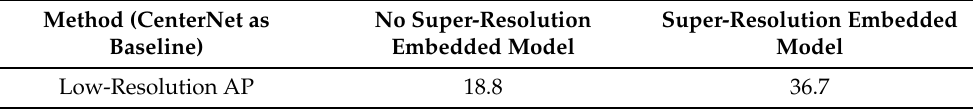
Table 5. Ablation Experiments on Super